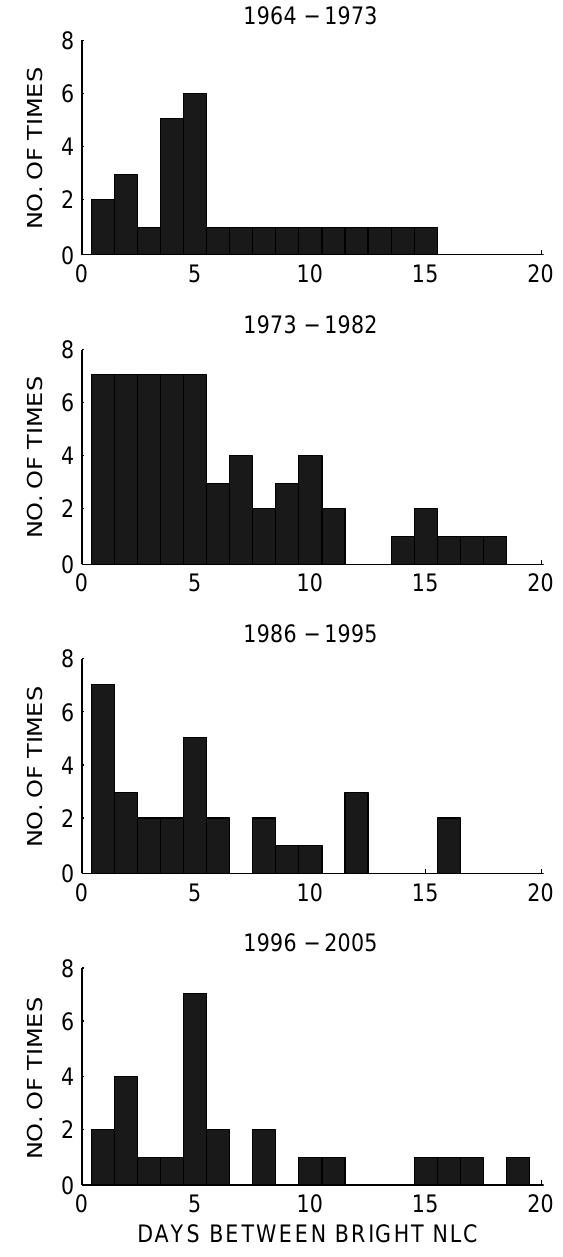
Fig. 7. Histograms of the number of days between consecutive bright or very bright NLC displays, for the decades indicated at the top of the panels. first three decades the same as in Fig. 3. There is a clear peak at 5 days in 3 of the 4 histograms. This is the same result as reported by Kirkwood and Stebel (2003) where the peak was identified as caused by 5-day planetary waves, and likely corresponds to case (a) in Fig. 6. In the decade